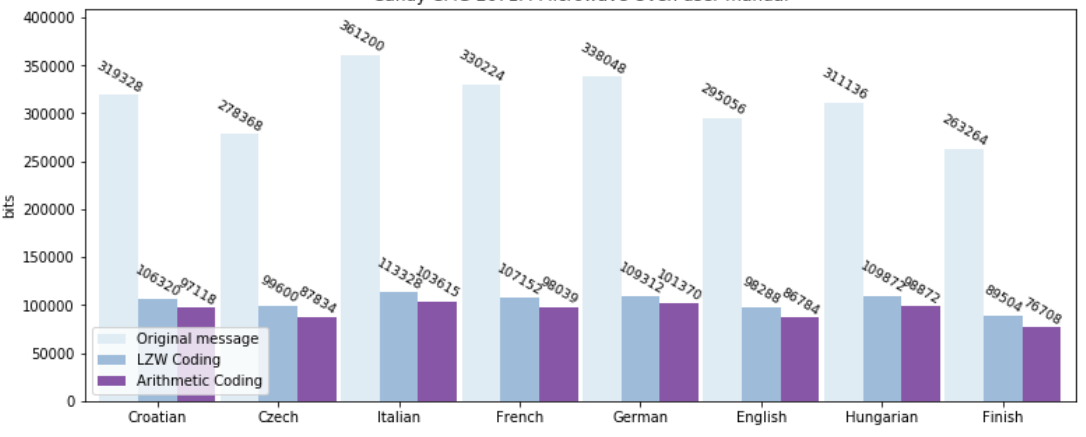
Figure 9. Encoding Candy CMG 2071M Microwave Oven user